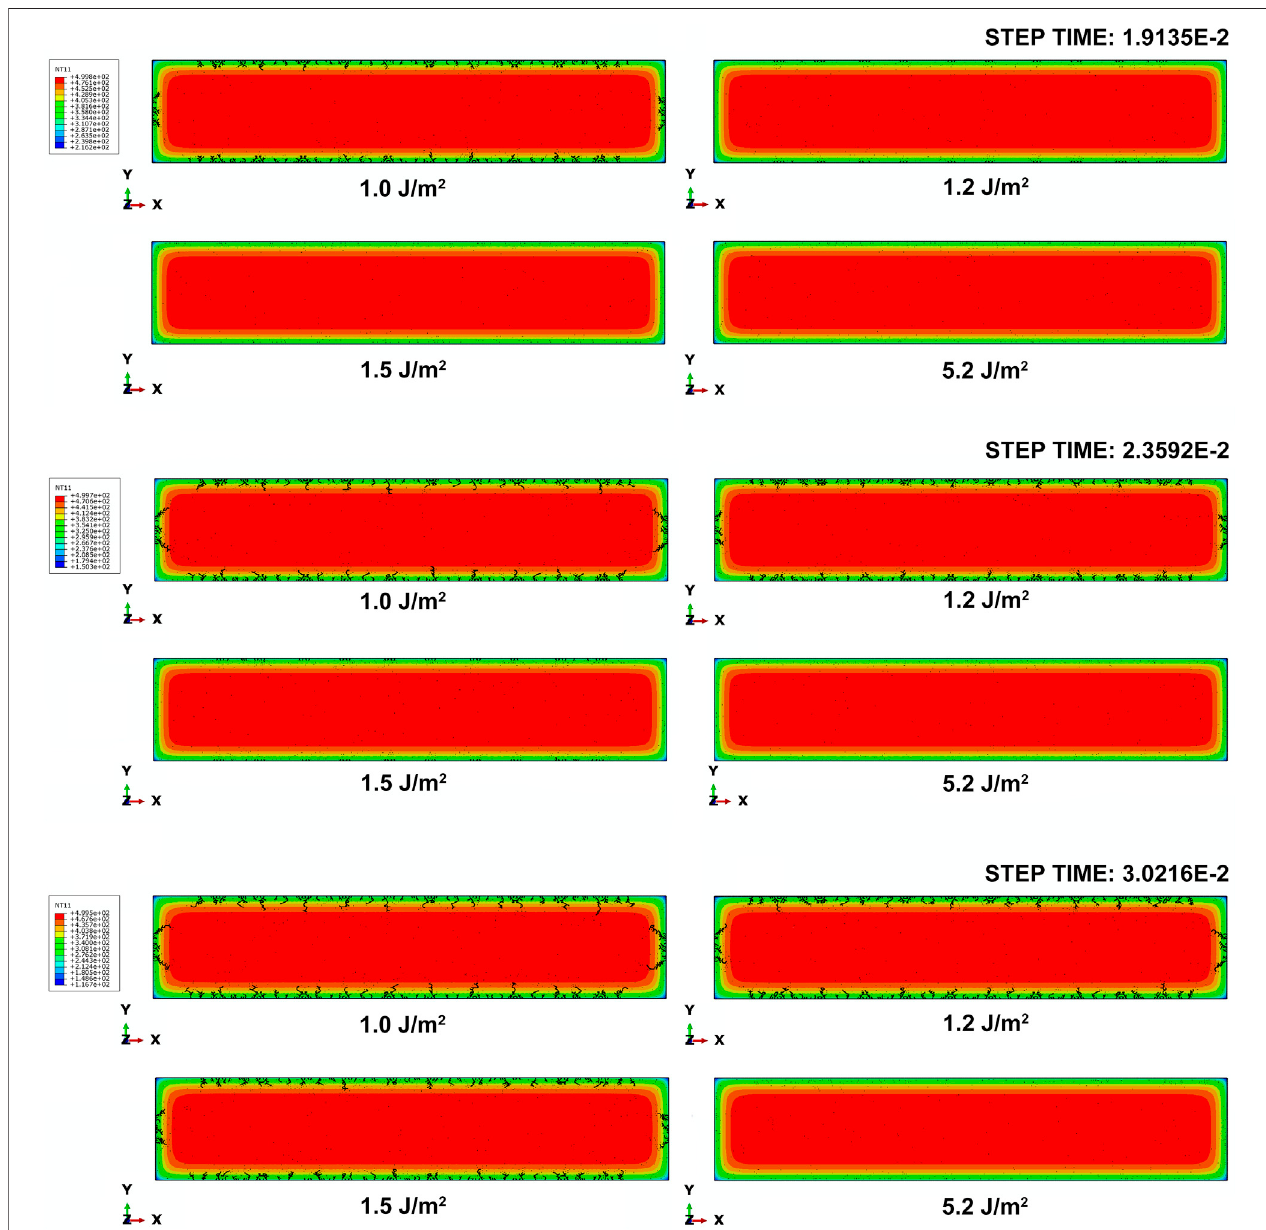
FIGURE 10 | Crack patterns of 1, 1.2, 1.5, and 5.2 J/m 2 grain boundary fracture energy models at step time 1.9135, 2.3592, and 3.0216 E − 2 ,